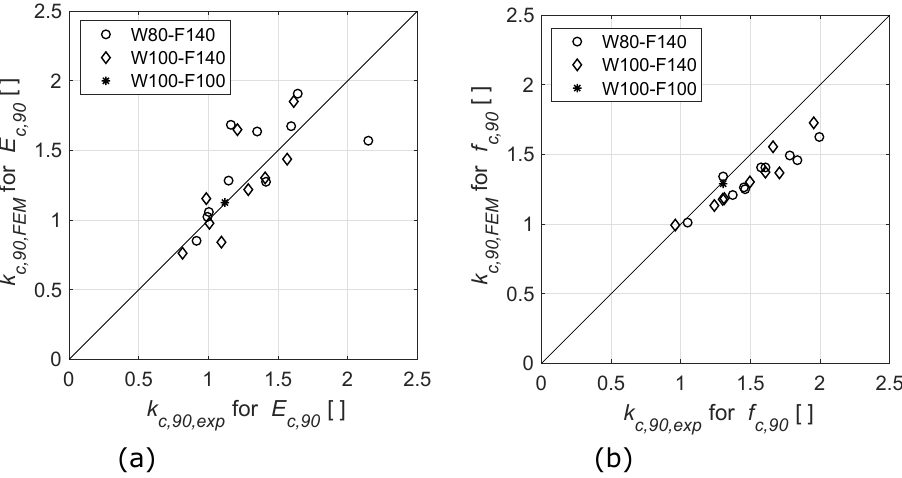
Figure 9. Correlation plot of ( a ) k c ,90 for E c ,90 and ( b ) k c ,90 for f c ,90 from FEM and